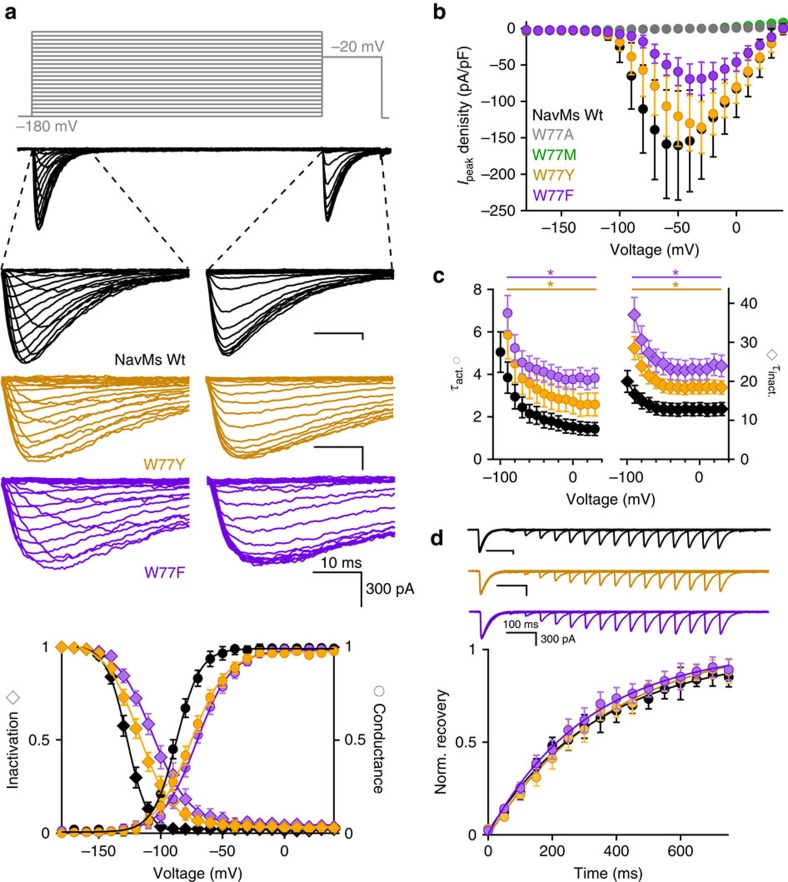
Perturbations of NavMs channel kinetics and voltage dependence by W77 mutations.(a) The voltage dependence of NavMs channels. Top, grey lines indicate voltage protocol use to open and inactivate the sodium channels. Middle, exemplar sodium currents conducted by the indicated wild type (WT) and mutant NavMs channels with expanded time scale indicated by the dashed line. Bottom, resulting voltage dependence of normalized channel conductance and inactivation. (b) Current density of Wt and W77 mutant NavMs channels (c) Average time constants of entry into activation (τact.) and inactivation (τinact.) obtained by fitting the initial rise and subsequent decay of the sodium currents (see Methods) to a single exponential. The star indicates P<0.05 resulting from a two tailed Student's t-test compared with the Wt values. (d) Rate of recovery from inactivation. Top, exemplar sodium currents were completely inactivated by a 150 ms depolarization 40 mV positive to the V1/2 of activation. The membrane potential was then held at −180 mV for varying time intervals; recovery was assessed by a second depolarization. The proportion of second to the first depolarization is the normalized recovery from inactivation. For all of the results in this figure, N=8 cells, Error=s.d.